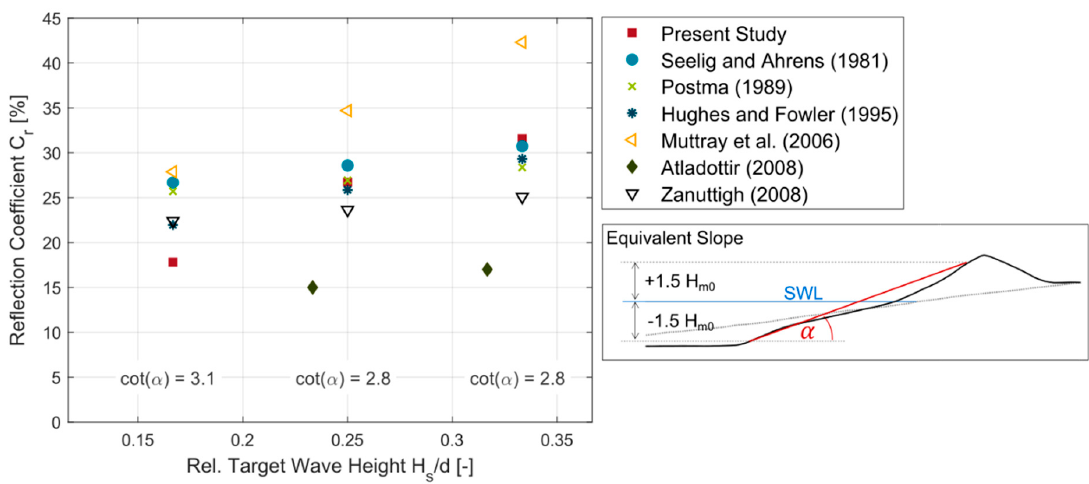
Figure 13. Reflection coefficients for gravel beach without structures in comparison to predicted values from literature; beach slope approximated between − 1.5 and 1.5 H m0 for prediction equations.